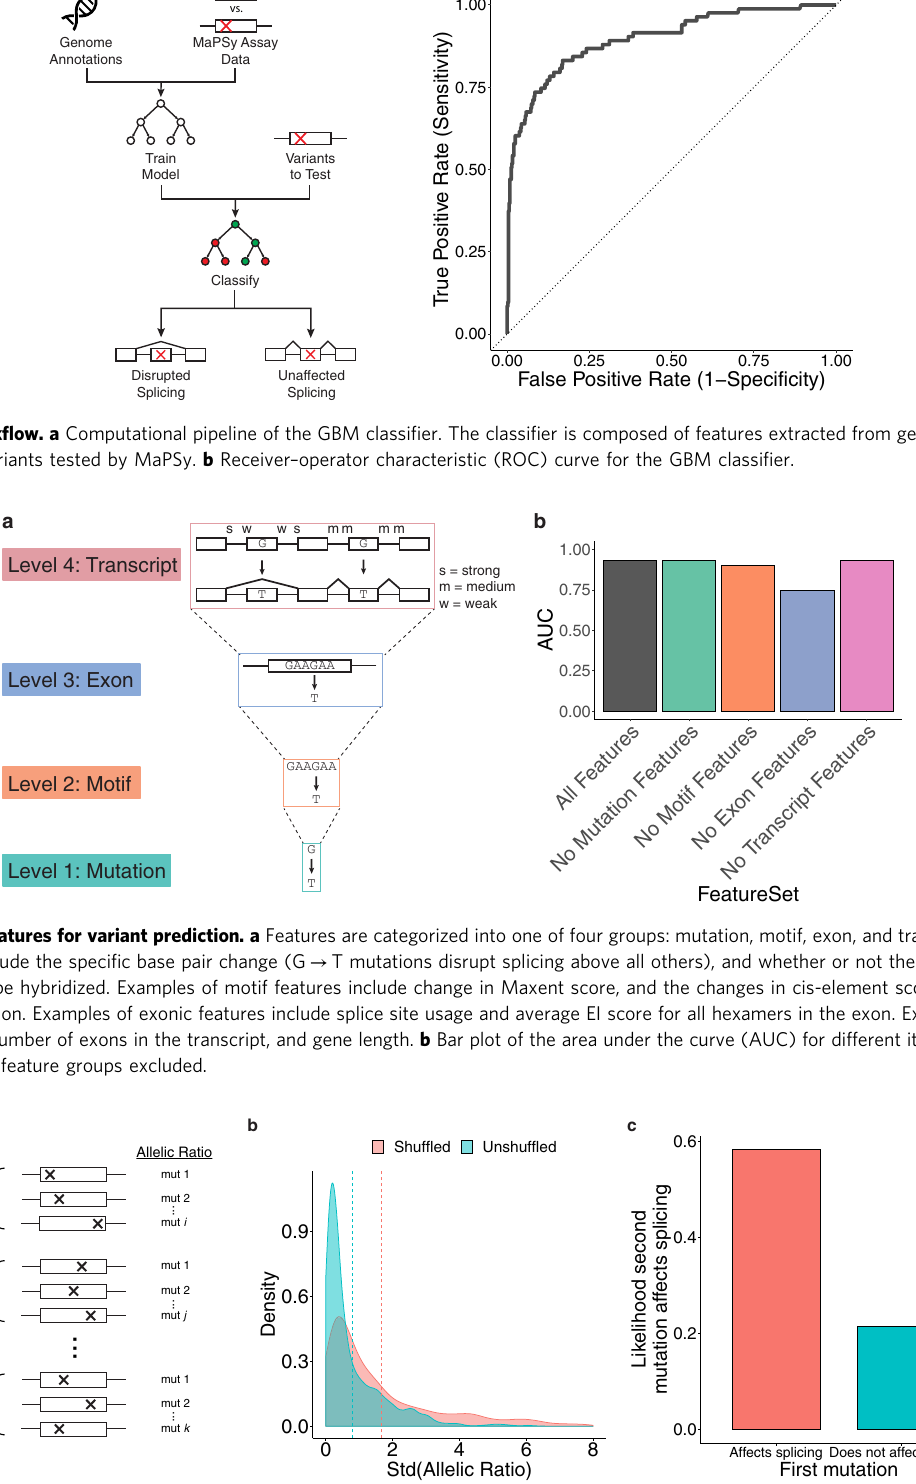
Fig. 3 Variants within the same exon are likely to have similar allelic ratios. a Exons from the MaPSy study were selected if they contained more than one variant which was assayed for allelic ratio ( n = 1017). The standard deviation of allelic ratio was calculated for each exon. b Distributions of the standard deviations before and after shuf fl ing allelic ratio values across all exons. Dashed lines represent the median values for the unshuf fl ed (left) and shuf fl ed (right) distributions. c Conditional probabilities that a randomly sampled exonic mutation will affect splicing depending on whether or not a previously sampled mutation in the same exon affects